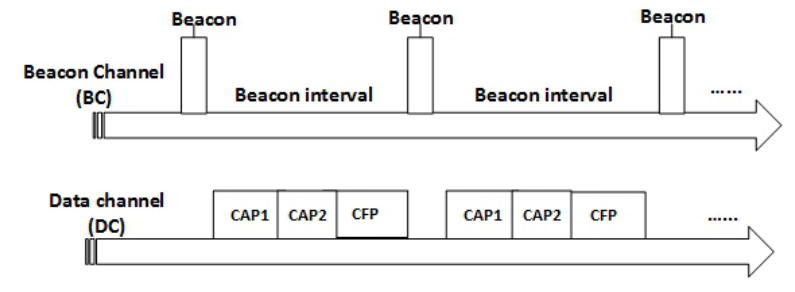
Figure 5. Channels in TAP-MAC.